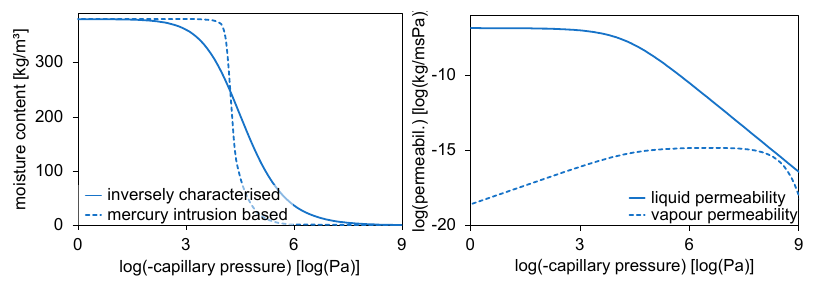
Figure 1. ( left ) Moisture retention curve for the OPS limestone, as inversely characterized or based on mercury intrusion; ( right ) liquid and vapour permeability (both related to gradients in capillary pressure) curves for the OPS limestone.